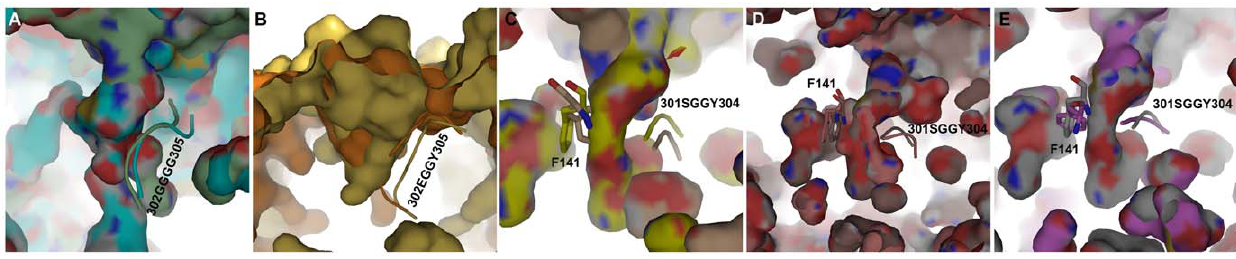
Figure 7. The arrangement of tunnel-lining residues in initial and average structures of all HDAC systems. (A) Initial and average structures of HDAC8 are shown in cyan and pale green colors. (B) Initial and average structures of HDAC10 are shown in dark and light orange colors. (C) Initial and average structures of HDAC11 WT are shown in yellow and wheat colors. (D) Initial and average structures of HDAC11 L268M are shown in dark salmon and salmon colors. (E) Initial and average structures of HDAC11 L268E are shown in violet and grey colors, respectively.